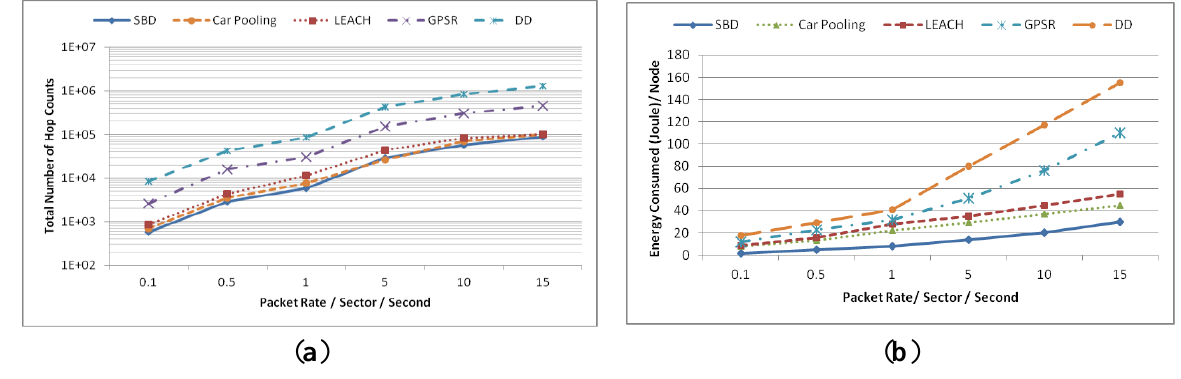
Figure 10. ( a ) Average energy consumption per node (joule) and ( b ) total number of hops (number of hops in storage and query routing).